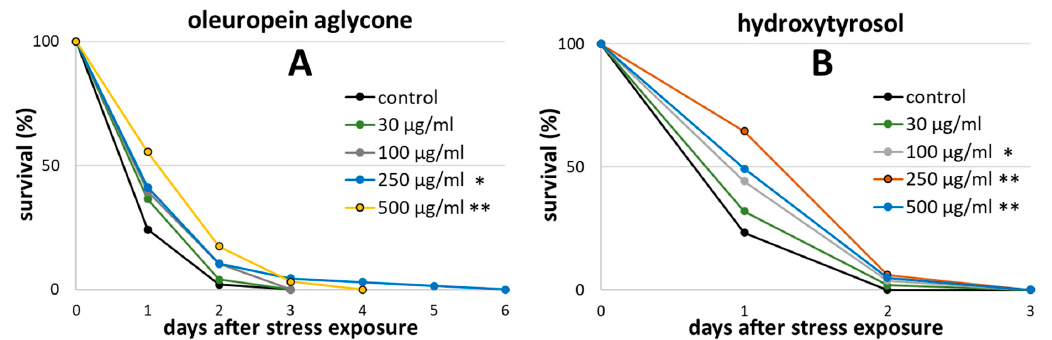
Figure 2. Heat stress survival in presence of di ff erent OLE and HT concentrations. Survival is expressed as a percentage of the initial population combined with three biological replications. At the third day of adulthood (day 0), wild type nematodes were exposed to heat stress at 37 ◦ C for 3 h prior monitoring survival. ( A ) Survival curves during OLE treatment with n (control) = 70, n (30 µ g / mL) = 74, n (100 µ g / mL) = 44, n (250 µ g / mL) = 68, and n (500 µ g / mL) = 64; ( B ) Survival curves during HT treatment with n (control) = 90, n (30 µ g / mL) = 50, n (100 µ g / mL) = 52, n (250 µ g / mL) = 67, and n (500 µ g / mL) = 79. Statistical significance was calculated by log-rank test including Bonferroni correction. Di ff erences compared to control were considered significant at p < 0.05 (*) and p < 0.001 (**). n : number of tested nematodes.